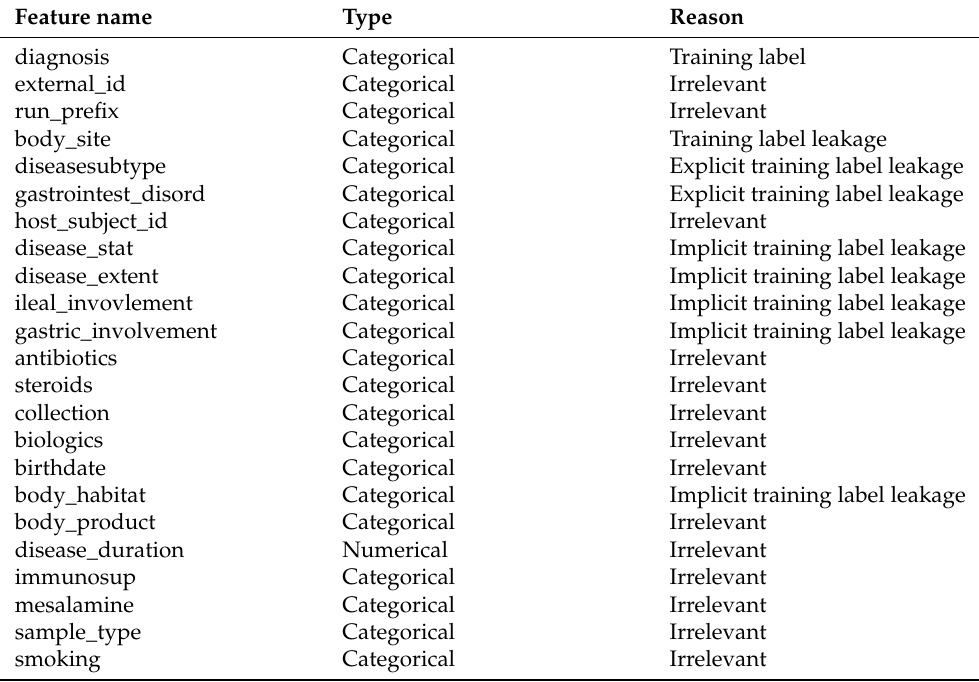
Table A1. List of features removed from the inflammatory bowel disease clinical view dataset.